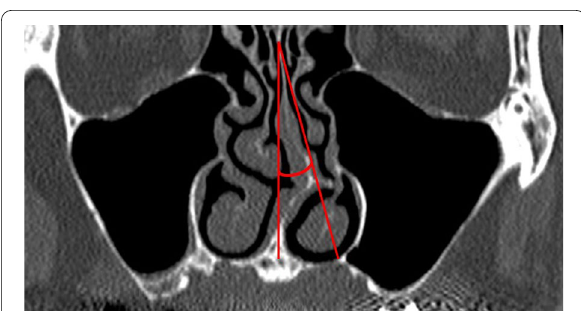
Fig. 2 Method for measuring NSD. NSD nasal septal